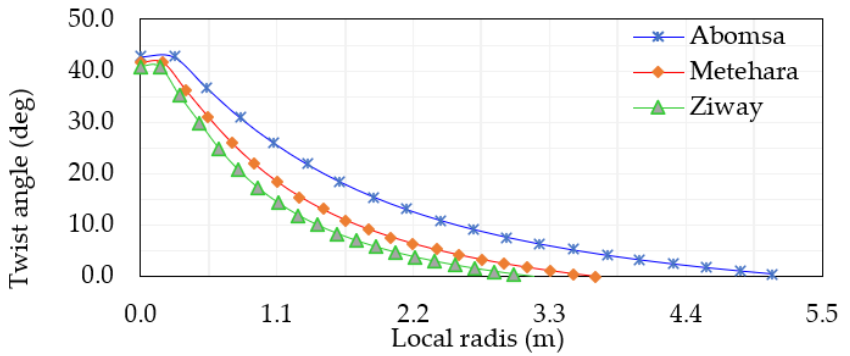
Figure 11. Comparison of chord distribution of three specific local sites.